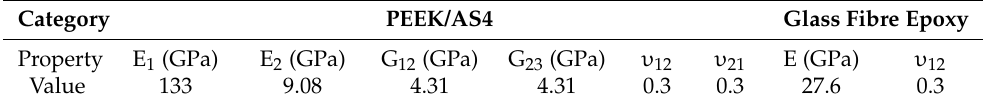
Table 3. Properties of PEEK/AS4 unidirectional lamina and glass fibre epoxy